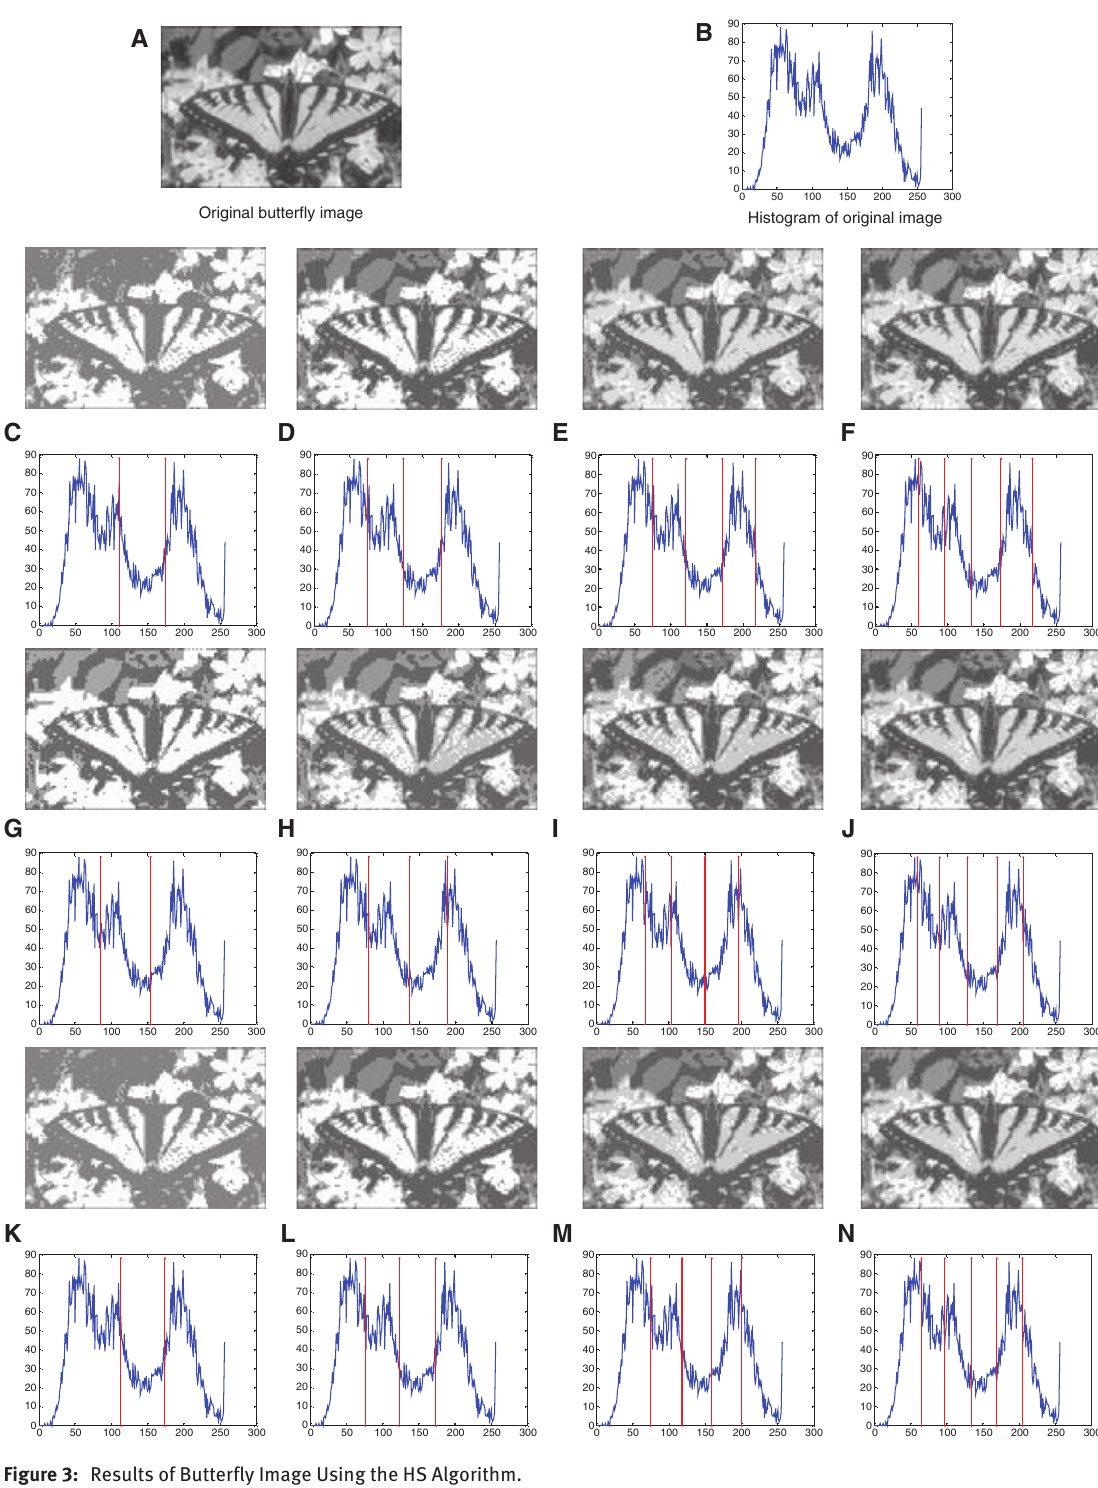
Figure 3: Results of Butterfly Image Using the HS Algorithm. (A) Original butterfly image, (B) histogram of original image, (C–F) two-level to five-level thresholding-based segmented image with the best thresholds obtained from the HS algorithm using Kapur’s entropy criterion, (G–J) two-level to five-level corre- sponding histogram labeled with the best threshold values obtained from the HS algorithm based on the between-class vari- ance criterion, (K–N) two-level to five-level thresholding-based segmented image with the best thresholds obtained from the HS algorithm using Tsallis entropy